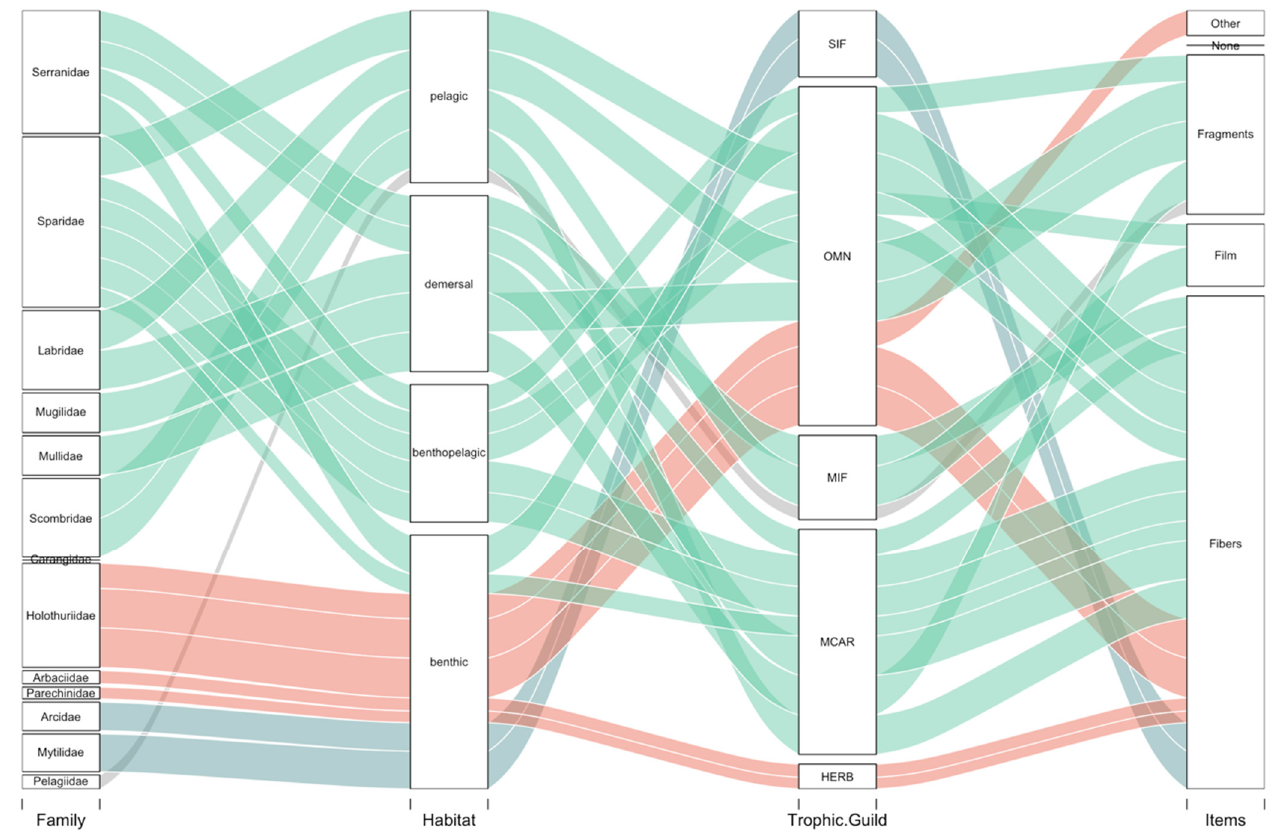
Figure 8. Alluvial diagram of the species by family: fish (green), echinoderms (red), bivalves (blue), cnidaria (grey); habitat: pelagic, benthopelagic, demersal, and benthic; trophic guild: mobile invertebrate feeders (MIF), macro-carnivores (MCAR), omnivores (OMN), sessile invertebrate feeder (SIF) and ingested items: fragments, fibres, films and other. The width of the flows considers the percent occurrence of ingestion for each of the species.